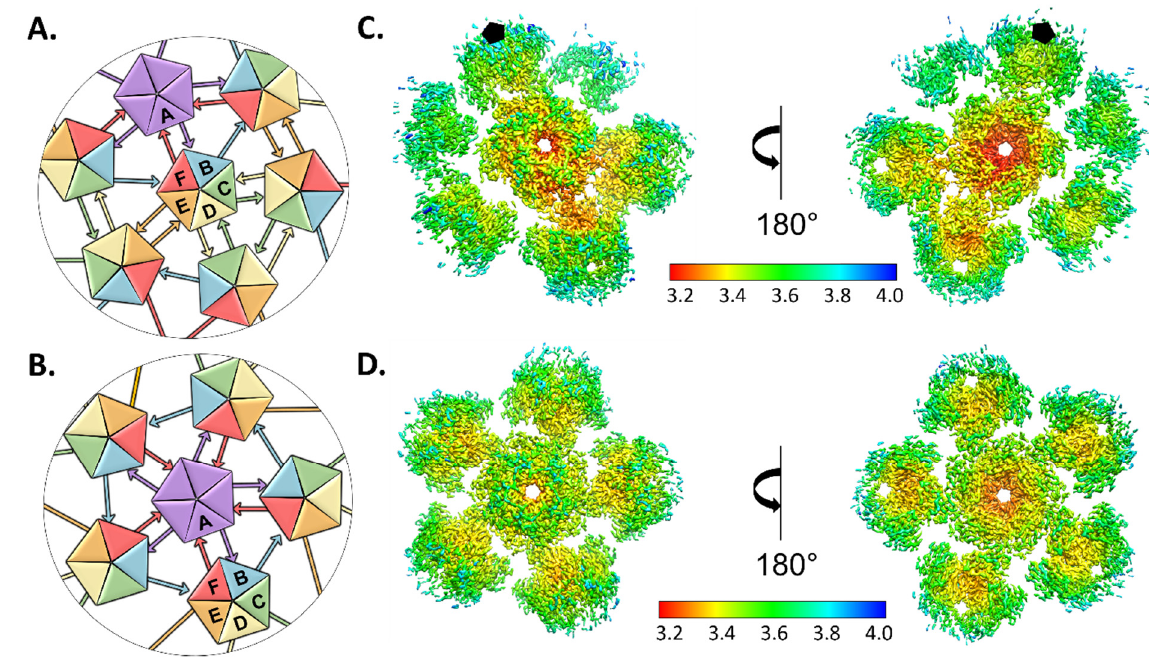
Figure 2. Local refinement of hexavalent and pentavalent capsomers. ( A , B ) With this analysis the cartoon has been modified from Goetschius and Hartmann et al., 2021 to display accurately the donating and receiving connecting arms [17]. Illustrated graphically by cartoons of pentavalent and hexavalent capsomers, the papillomavirus capsid asymmetric unit is made up of six L1 chains, labeled chain A–F and colored purple, blue, green, yellow, orange, and red, respectively. ( A ) Each A chain of the pentavalent capsomer makes a connection with chain F of the neighboring hexavalent capsomer, showing fivefold icosahedral symmetry. The pentavalent capsomer is surrounded by single arm connections of chain B to chain F in a counterclockwise ring contribution. ( B ) The threefold is comprised of C and D chains with each C chain (green) donating to chain D and D donating to C. Each E chain (orange) contributes to a neighboring E chain, showing twofold symmetry and this is the only case where the same arm conformation connects two capsomers. ( C , D ) Surface rendered